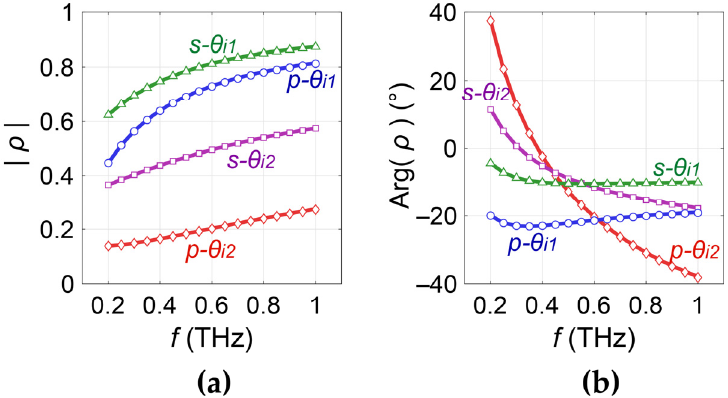
Figure 13. ( a ) The amplitude and ( b ) phase of the reflection ratios calculated for the four experimental geometries, indicated by s- θ i1 , p- θ i1 , s- θ i2 , and p- θ i2 . The symbols are the results from geometries, indicated by s- θ i 1 , p- θ i 1 , s- θ i 2 , and p- θ i 2 . The symbols are the results from the layered the layered model and the solid curves are the results from the anisotropic model [53]. model and the solid curves are the results from the anisotropic model